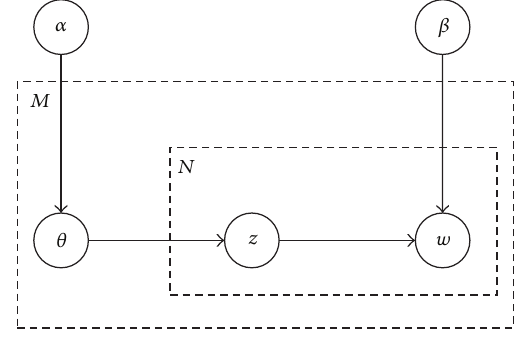
Figure 5: Representation of